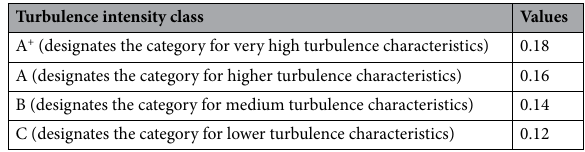
Table 1. Turbulence intensity